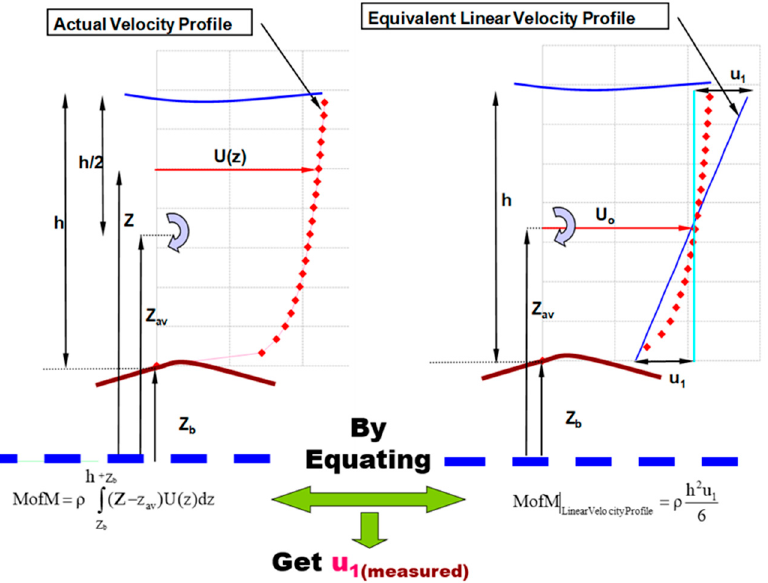
Figure 1. Definition of the moment velocity scale, u 1 .